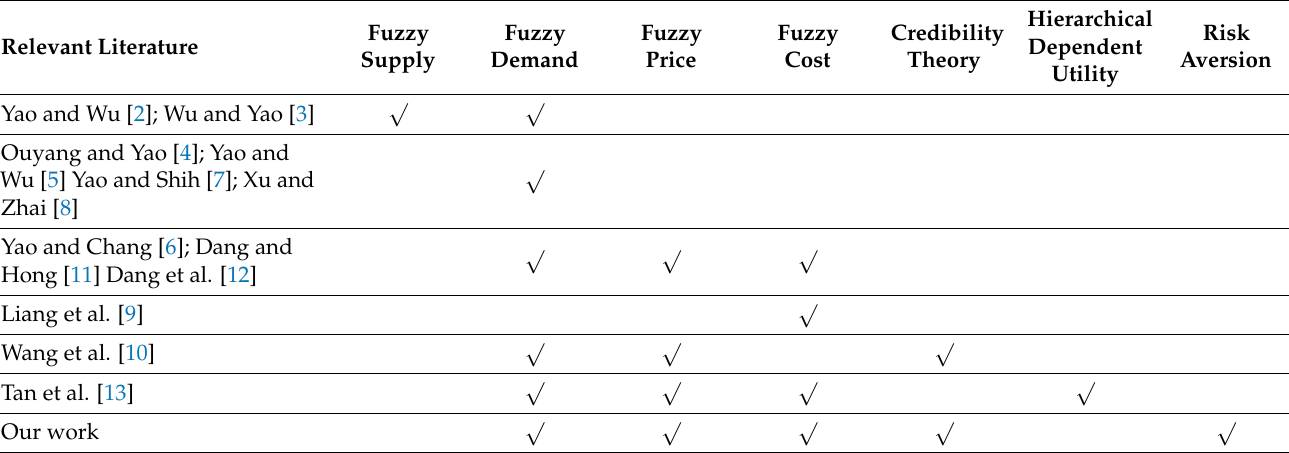
Table 1. Summary of